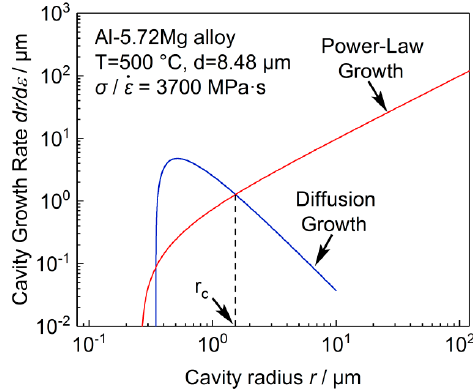
Figure 5. Schematic illustration of diffusion growth and plastic-controlled growth, showing the critical radius r c .